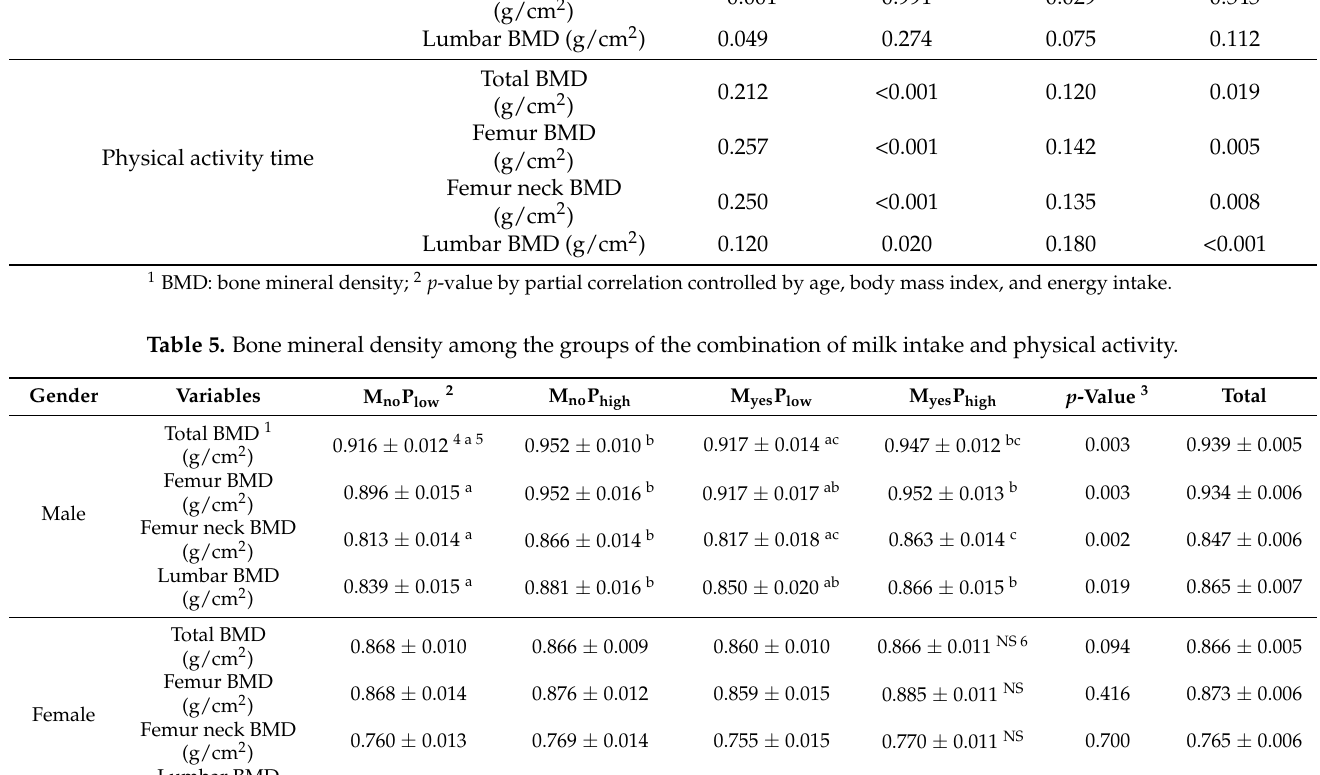
Table 6 lists the odds ratio and confidence interval (CI) for the 50th or higher percentile of the BMD value in each BMD variable for each group compared to the M yes P high group. Among males, the M no P low group had significantly lower odds ratio for the 50th percentile or higher of the BMD value than the M yes P high group in all BMD variables. More specifically, the M no P low group was 0.317 times less likely to have the 50th or higher percentile of total body BMD value than the M yes P high group. For femur, femur neck, and lumbar BMD, the M no P low group had 0.289, 0.512, and 0.493 times lower odds ratio for the 50th or higher percentile of the BMD compared to the M yes P high group. In other words, the ratio of individuals with a median or higher BMD was significantly lower among the males who did not drink milk and had a low level of physical activity than the males who consumed milk and had a high level of physical activity. Among the females, the M no P low group and M yes P low group were 0.433 and 0.434 times less likely, respectively, to have the 50th or higher percentile of lumbar BMD than the M yes P high